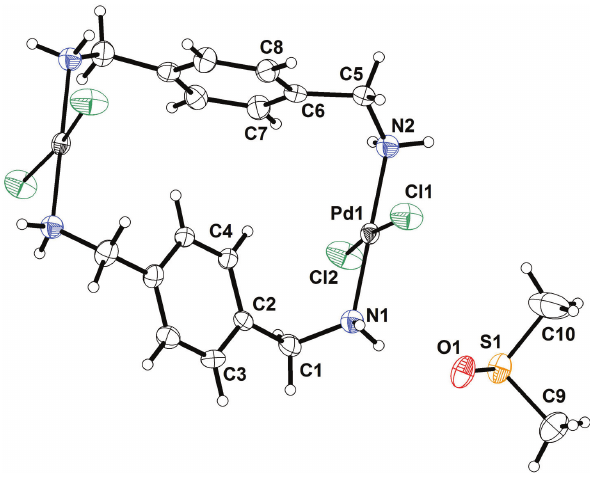
Table 2: Fractional atomic coordinates and isotropic or equivalent isotropic displacement parameters (Å 2